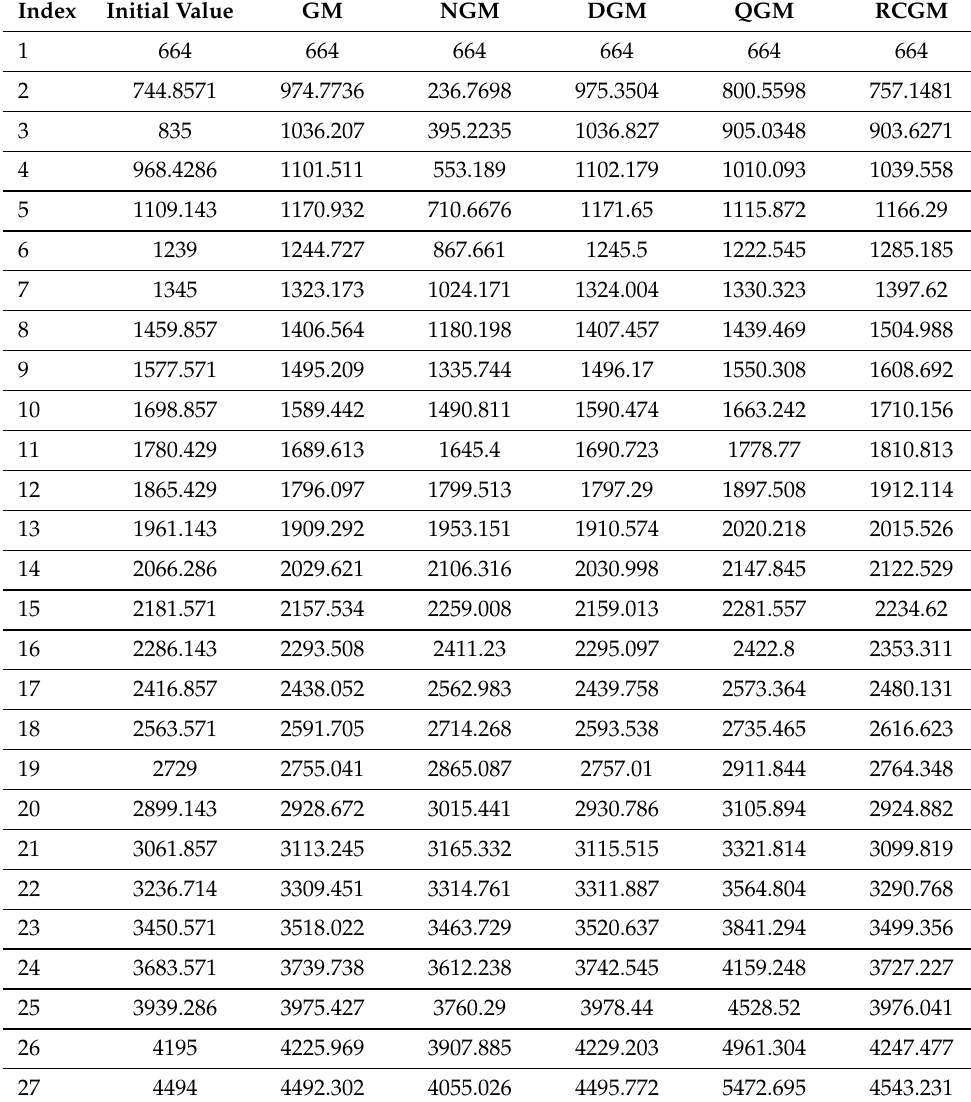
Table 5. Predicted values from Delhi data Model II.